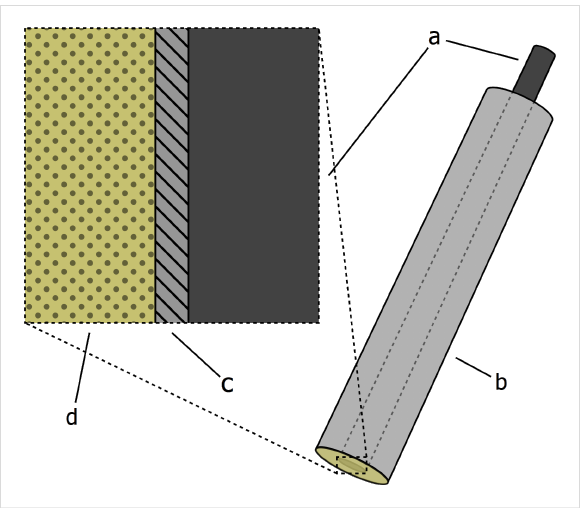
Figure 2: The structure of the solid-contact ion-selective electrode (sensor): a) glassy carbon as the electronic conductor; b) insulating shell made from PVC; c) PEDOT-Cl as the solid contact (ion-to-elec- tron transducer); d) an ion-selective membrane with a plasticized PVC matrix. The inset shows a cross-section of the center of the sensor